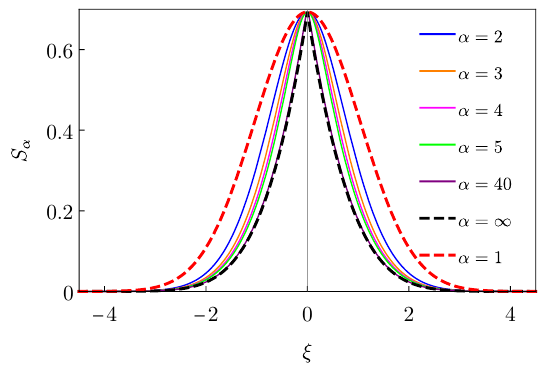
Figure 11: Asymptotic profile of operator entanglement for different values of Rényi indexes α . The dashed curves correspond to the extremal values of